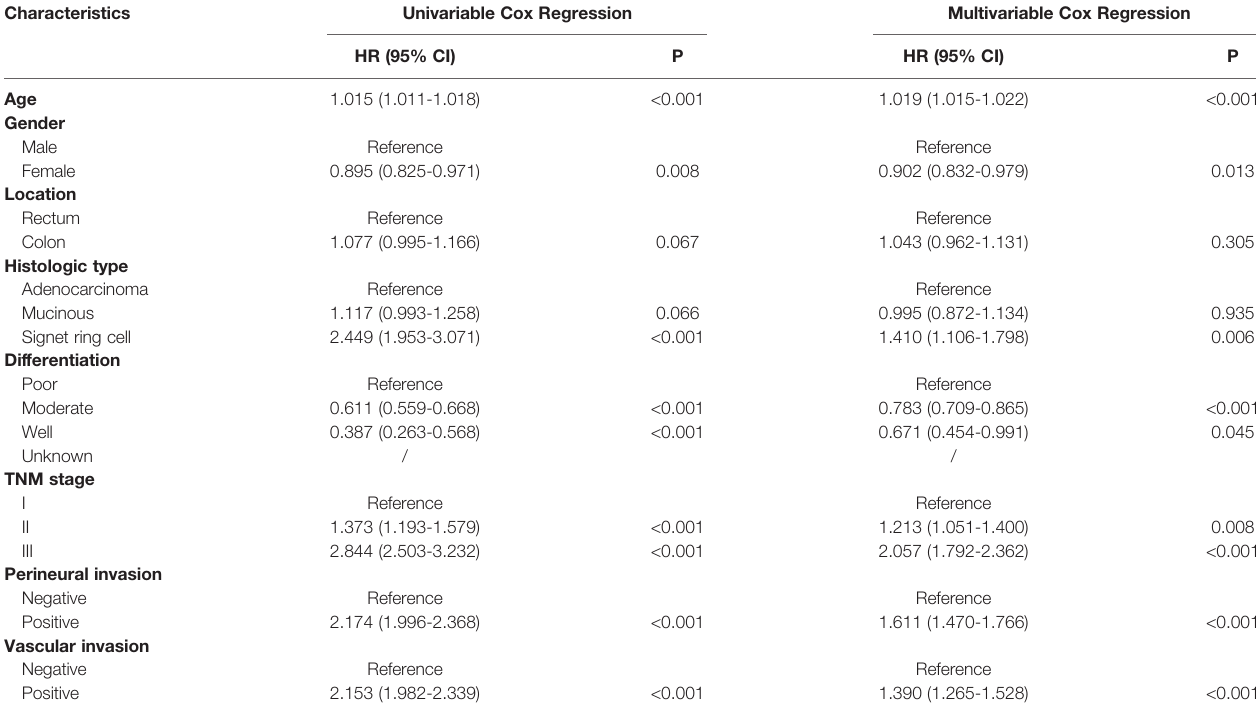
TABLE 2 | Univariable and multivariable Cox regression of disease-free survival in entire cohort. Characteristics